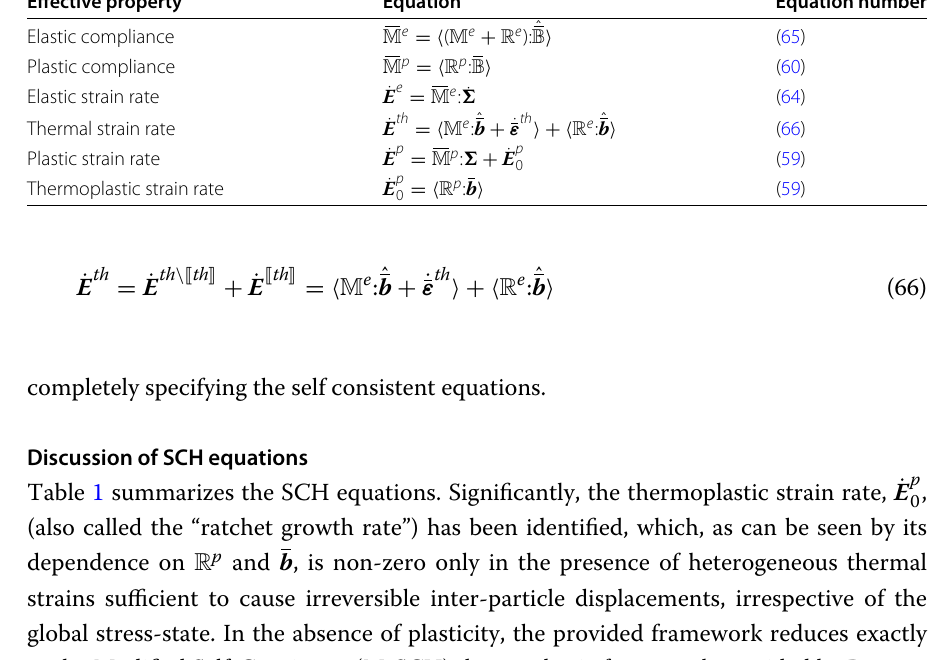
Table 1 Summary of homogenization equations Effective